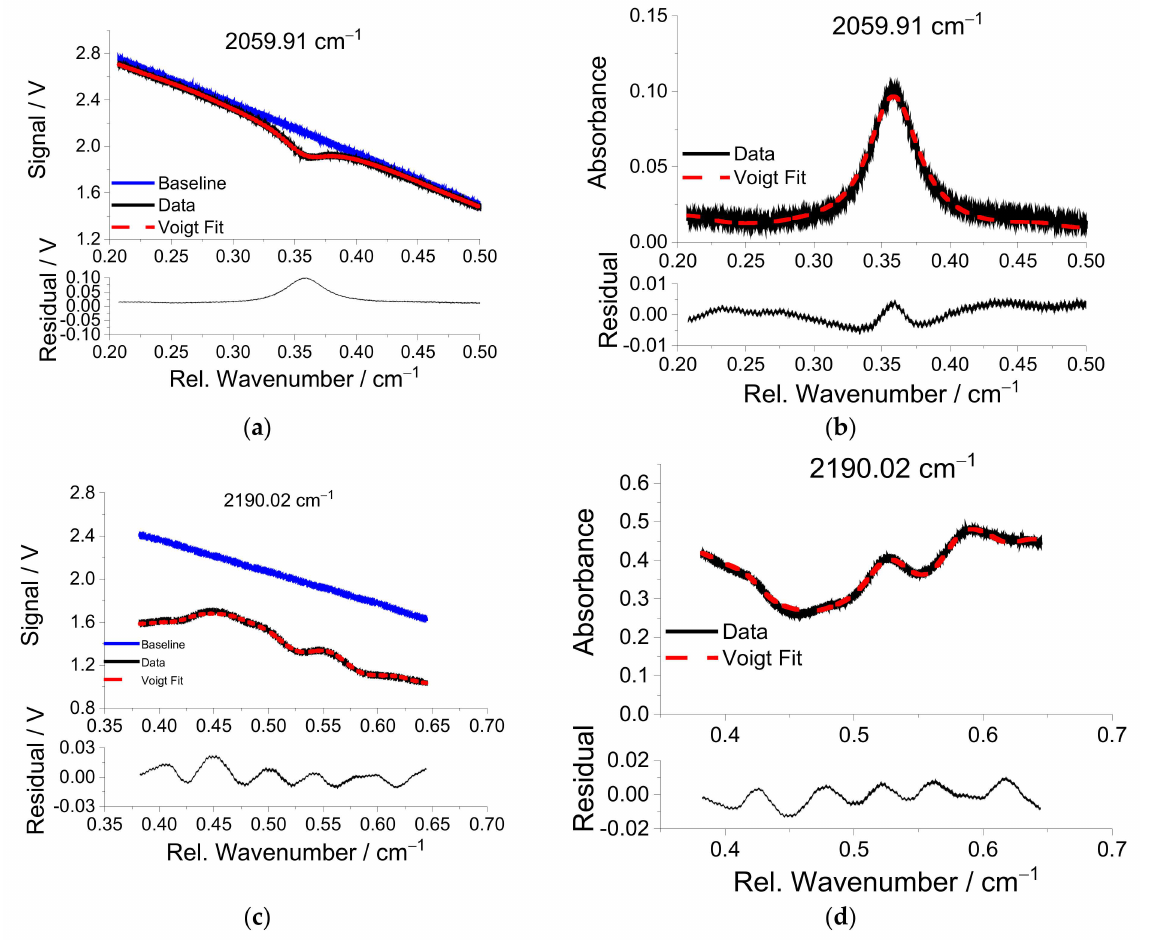
Figure 9. Transmitted signal and calculated absorbance originating from CO, CO 2 , and H 2 O over the relative wavenumber at the CO center wavelengths 2059.91 cm − 1 ( a , b ) and 2190.02 cm − 1 ( c , d ) for the premixed flame no.